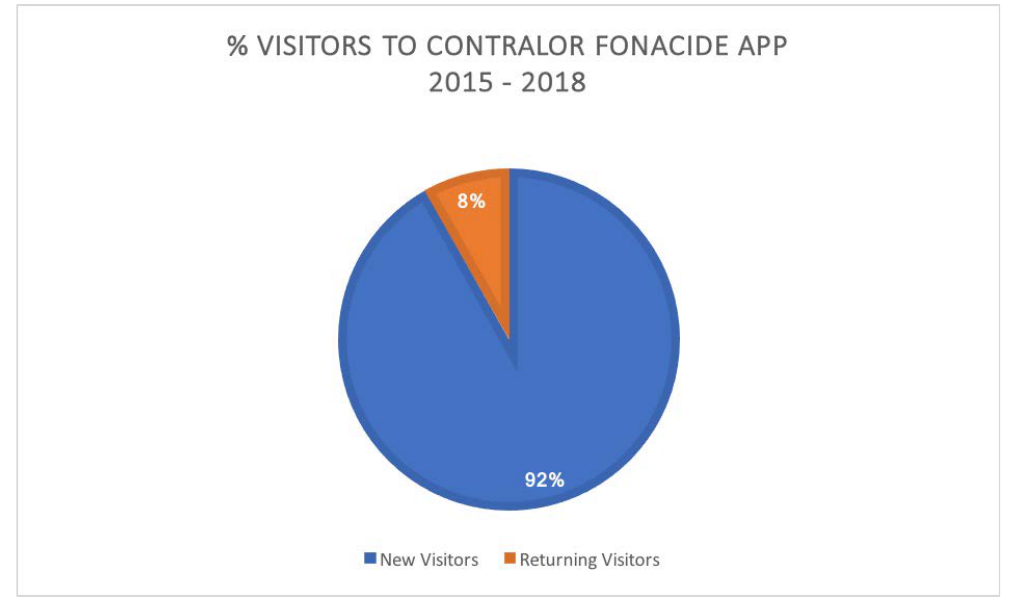
Source: Author’s elaboration. Figure 7: Percentage of New Visitors by Location